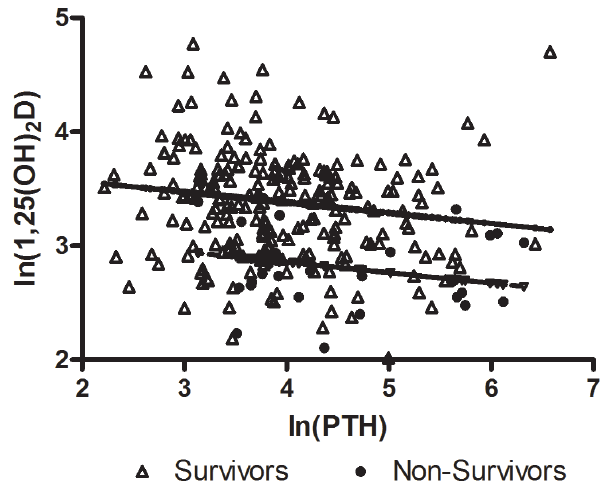
Figure 4. 1,25-dihydroxyvitamin D (1,25(OH) 2 D) as a function of parathyroid hormone (PTH). The plot shows that in both groups, there is a parallel decrease in ln(1,25(OH) 2 D) for increases in ln(PTH). In the survivors, this relationship is significant (p , 0.01). However, the change was not significant in the non-survivors possibly due to small number of subjects (p=0.80).